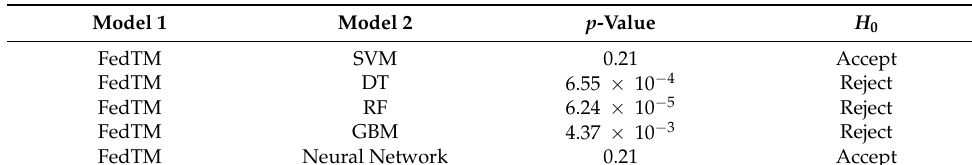
Table 6. Kolmogorov–Smirnov hypothesis test of the models.